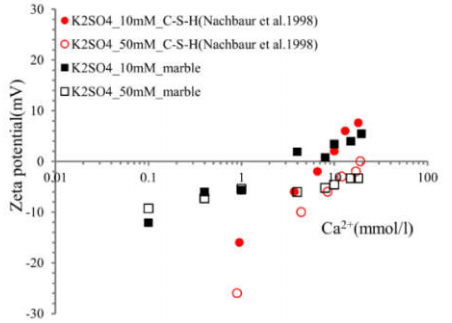
Figure 4. Development of the zeta potential of marble and C–S–H with increasing Ca 2 + concentration in 10 and 50 mmol / L K 2 SO 4